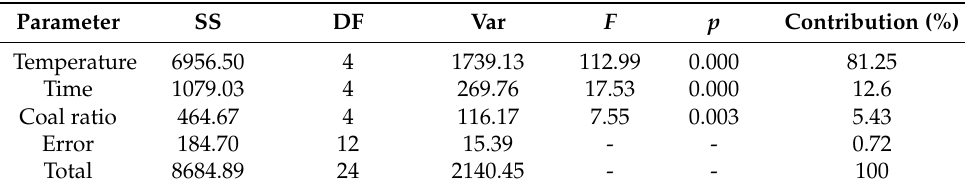
Table 6. Variance analysis results for the metallization rates of